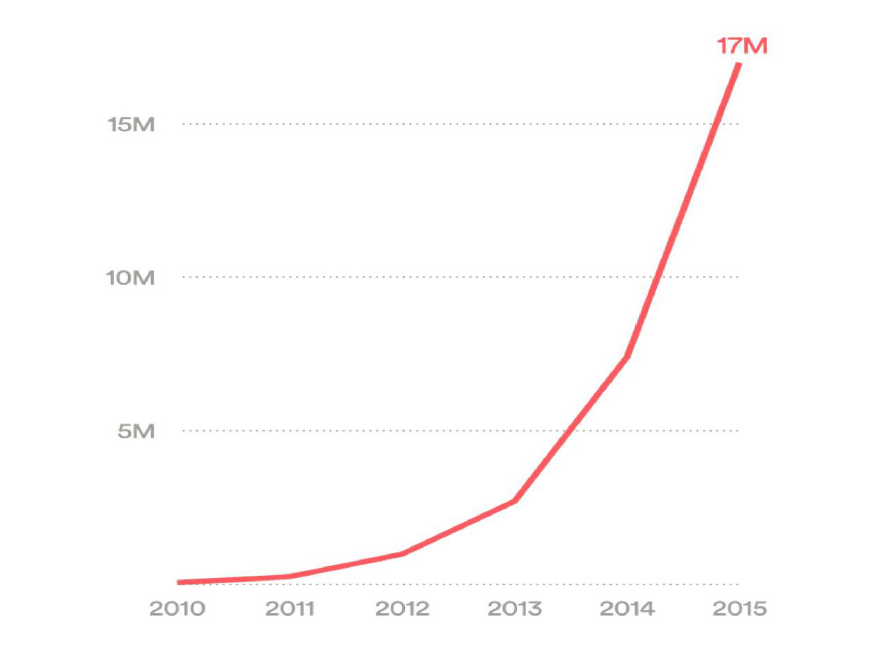
Figure 4: Airbnb Summer Travel